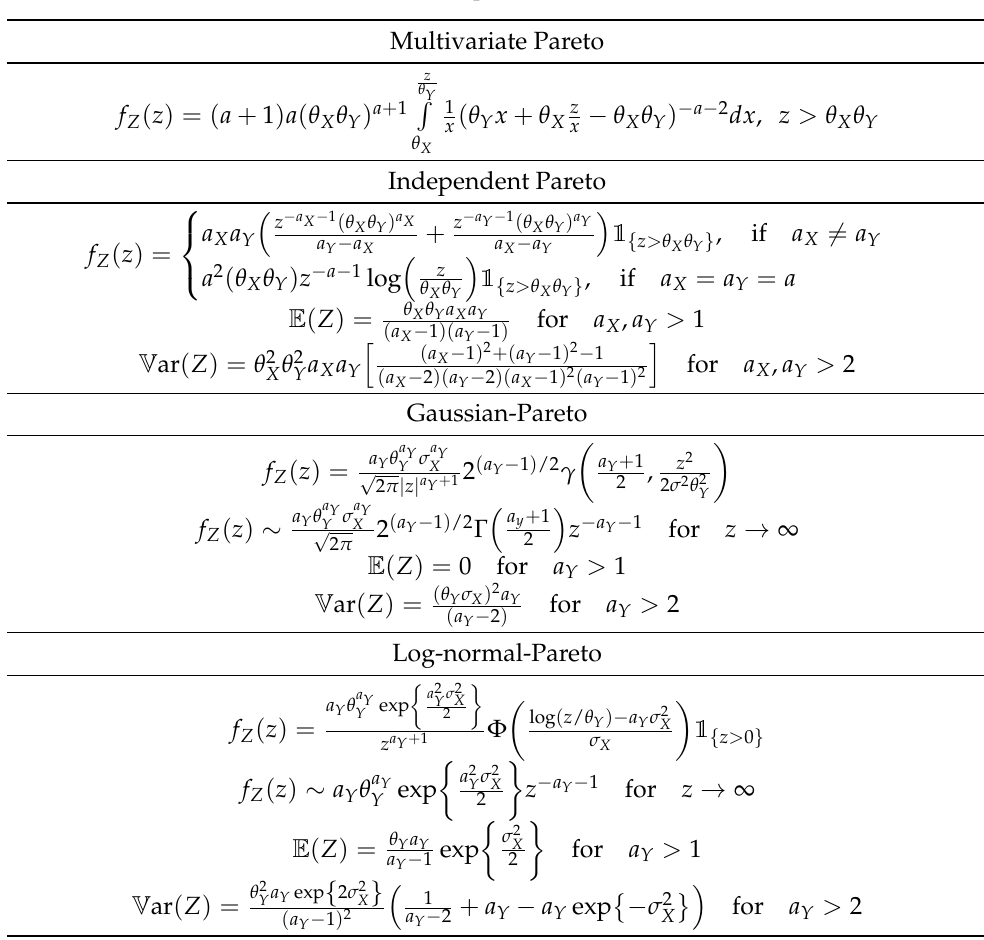
Table 2. Summary of the formulas for PDFs, f Z , its asymptotic behaviour for z → ∞ and two first moments, E ( Z ) and V ar ( Z ) for the considered products with Pareto